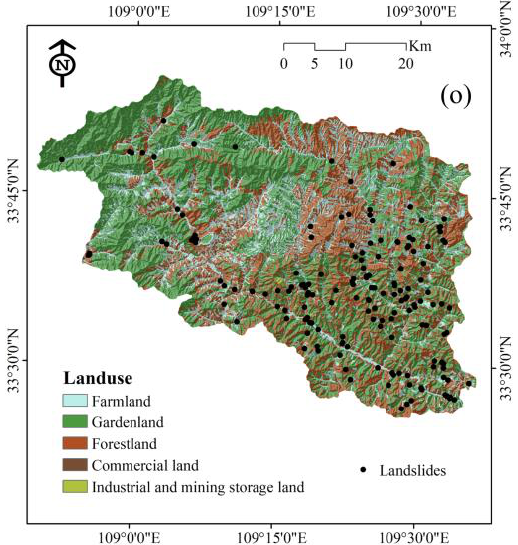
Figure 3. Thematic maps with landslide dataset of the study area: ( a ) Elevation; ( b ) slope angle; ( c ) slope aspect; ( d ) plan curvature; ( e ) profile curvature; ( f ) SPI; ( g ) STI; ( h ) TWI; ( i ) lithology; ( j ) distance to faults; ( k ) distance to rivers; ( l ) rainfall; ( m ) distance to roads; ( n ) NDVI; ( o ) land use.